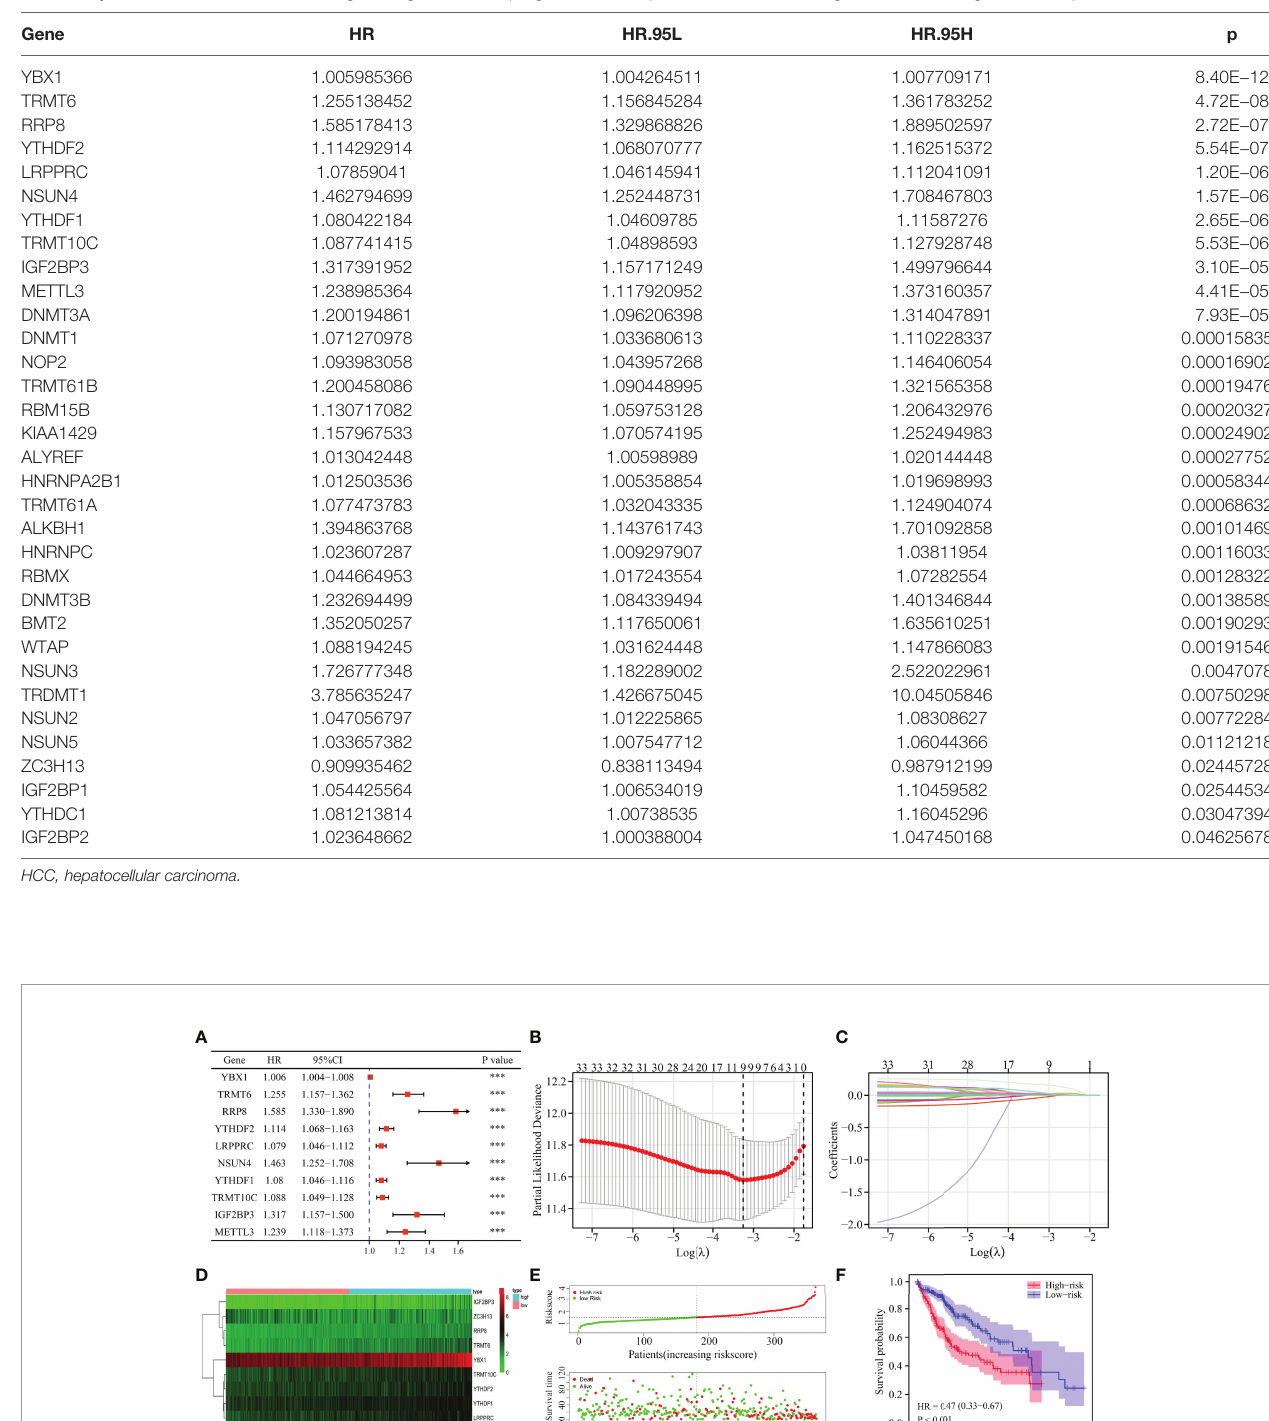
TABLE 4 | The effect of m6A/m1A/m5C regulated genes on the prognosis of HCC patients determined using univariate Cox regression analysis.